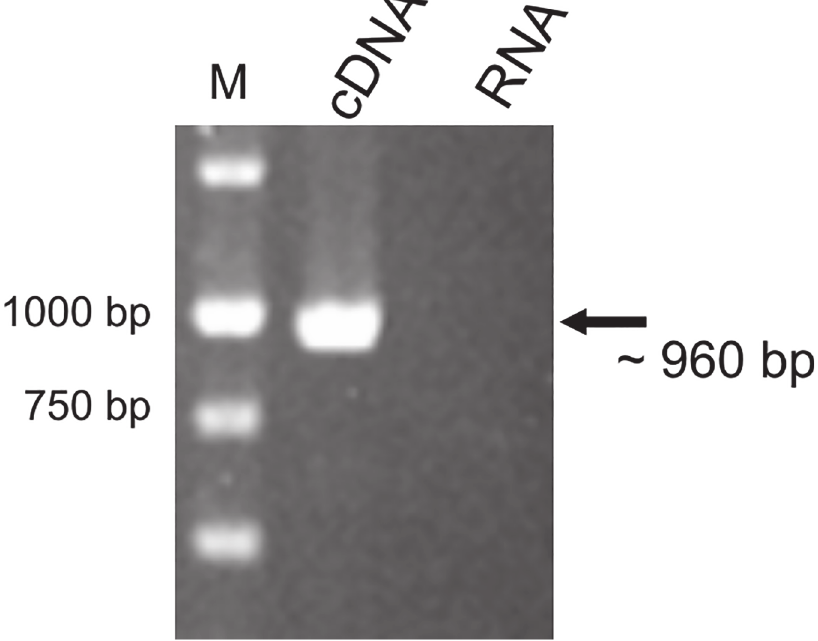
Fig 3. RT-PCR analysis of the acrRdsrE operon. The analysis was performed using total RNA isolated from strain Ye9 grown in LB medium at 27°C. The size of the amplified fragment was estimated by comparison with the size marker DNAs (lane M). A negative control reaction was performed using DNase- treated RNA as the template.